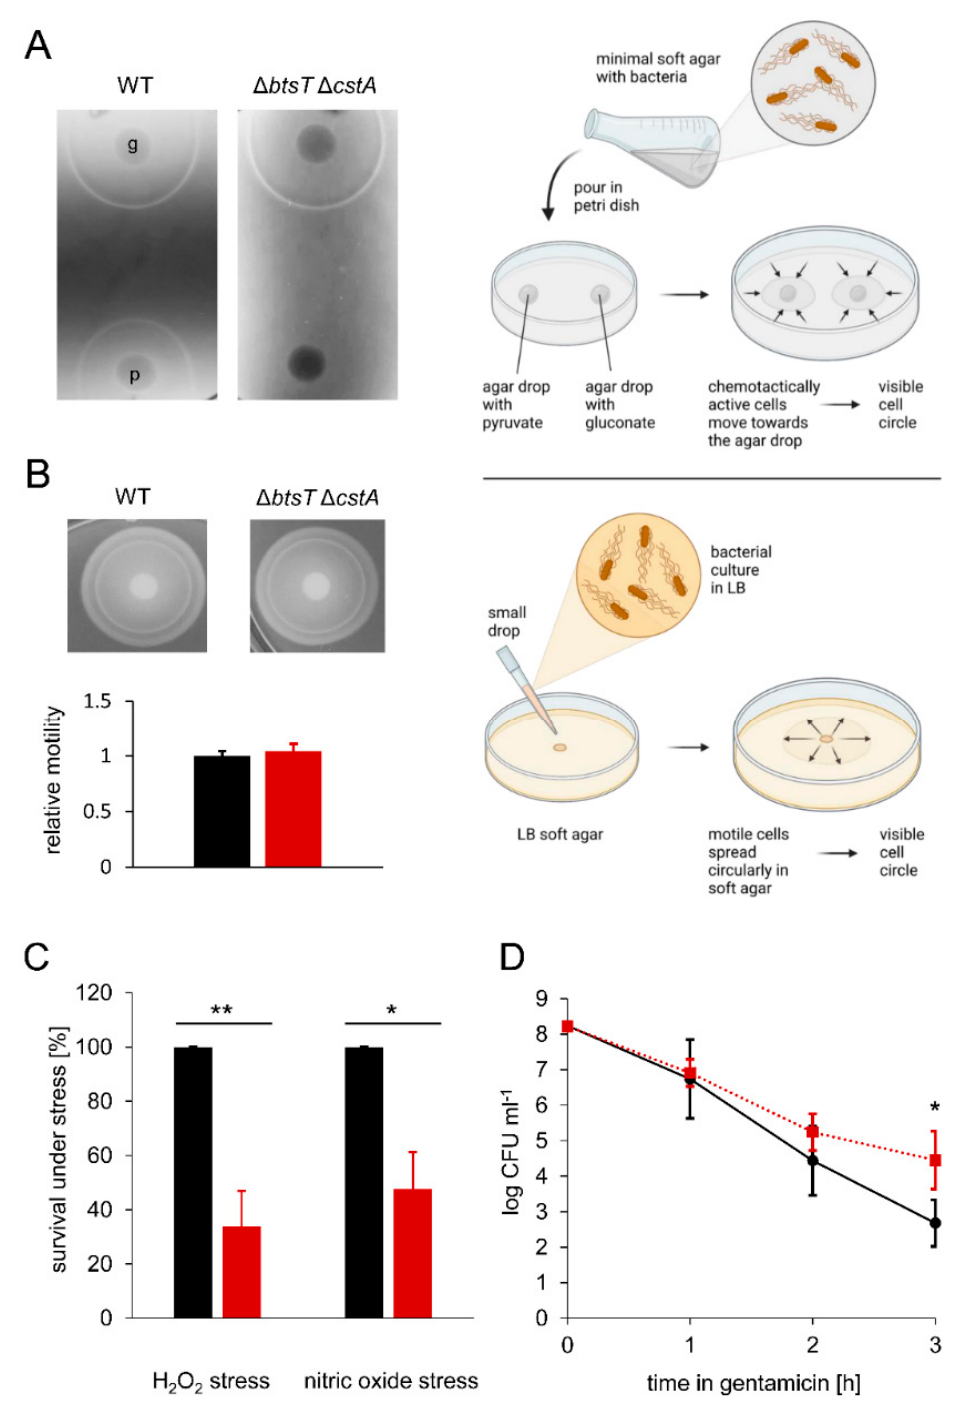
Figure 4. In vitro phenotypes of S . Typhimurium ∆ btsT ∆ cstA mutant. ( A ) Chemotaxis assay with schematic illustration: Chemotaxis was tested by mixing SL1344 wild-type (left) and ∆ btsT ∆ cstA (right) cells with 0.3% ( w/v ) M9 soft agar and pouring them over 1.5% ( w/v ) M9 agar plugs containing either 50 mM gluconate (g) or 50 mM pyruvate (p). Plates were incubated at 37 ◦ C for 4 h, and the pictures are representative of three independent experiments. ( B ) Swimming motility assay with schematic illustration: Motility of SL1344 wild-type (left, black) and ∆ btsT ∆ cstA (right, red) cells was tested by spotting equal numbers of cells on 0.3% ( w/v ) LB soft agar, incubating the plates at 37 ◦ C